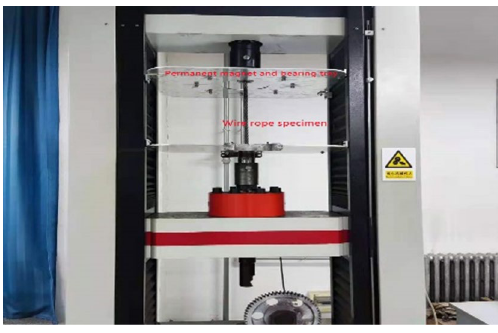
Fig. 15 Test wire rope and test point